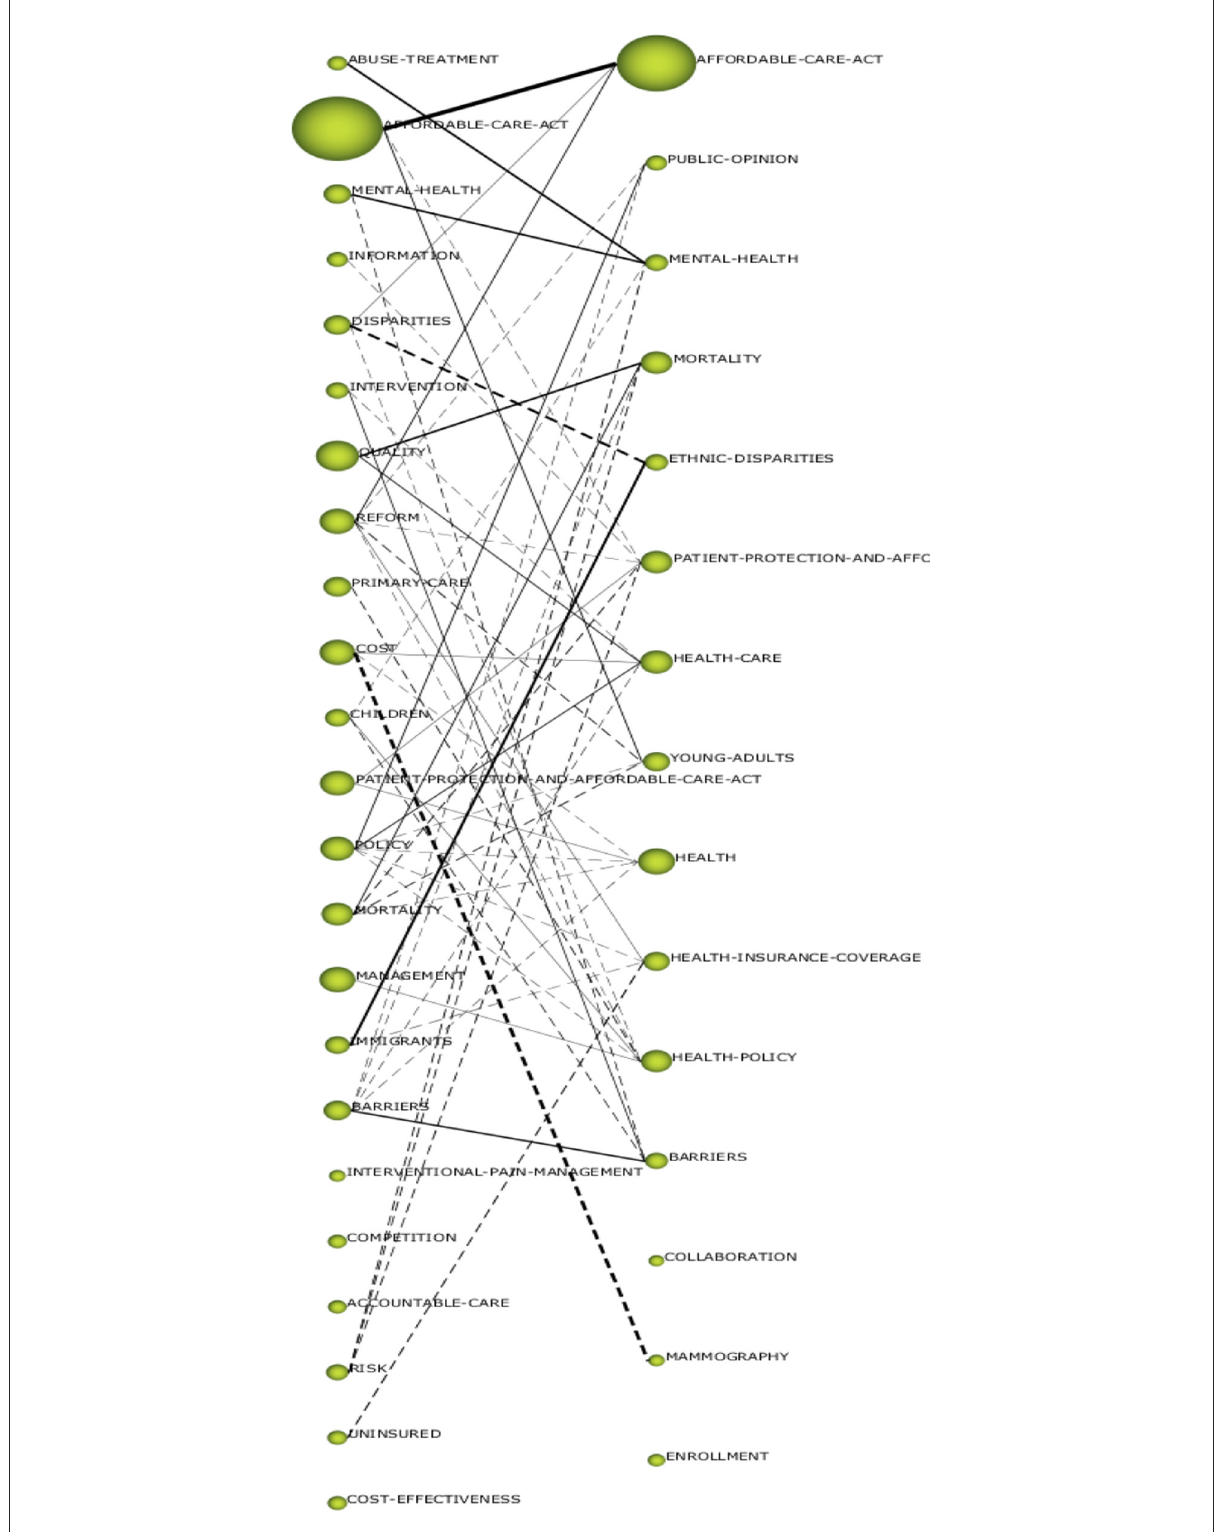
FIGURE6 Evolution diagram from the period “Until 2017” to the period